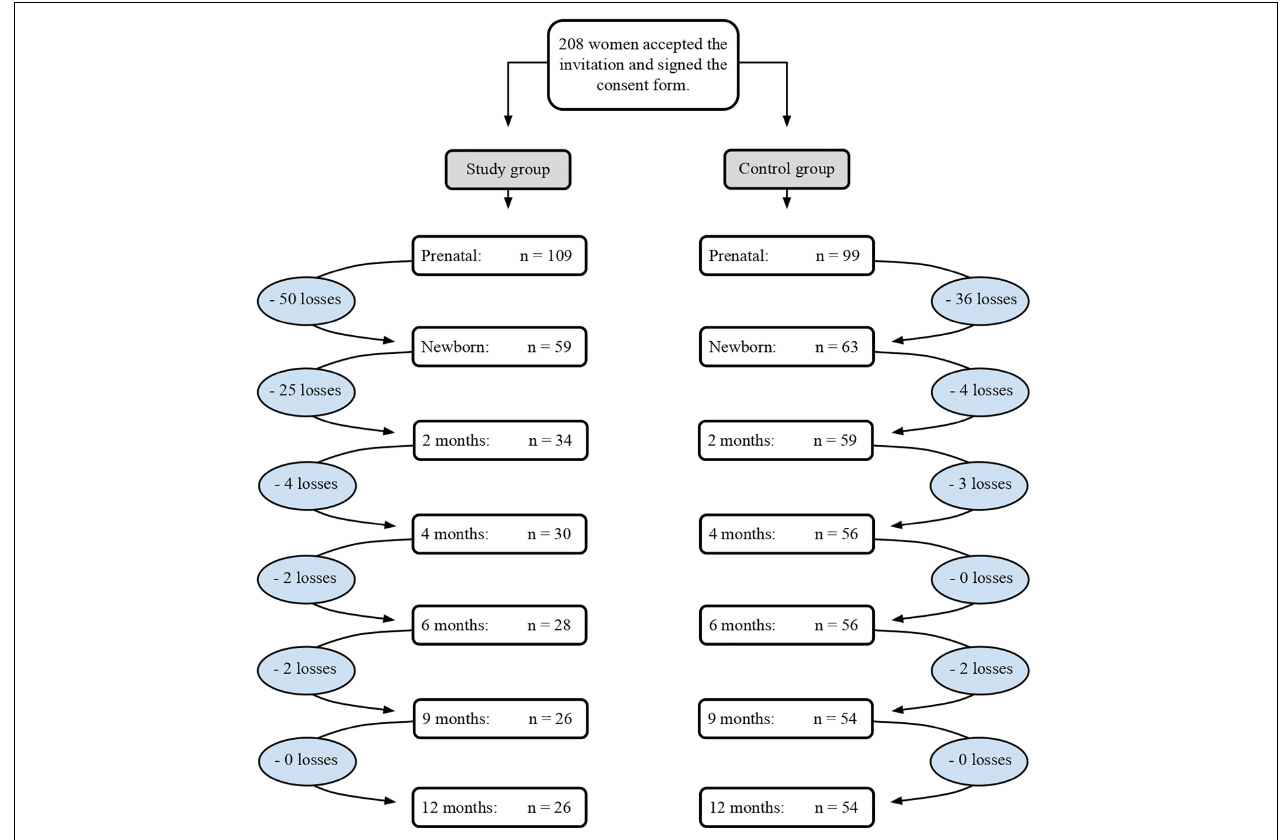
FIGURE 1 | Number of followed dyads until the completion of data